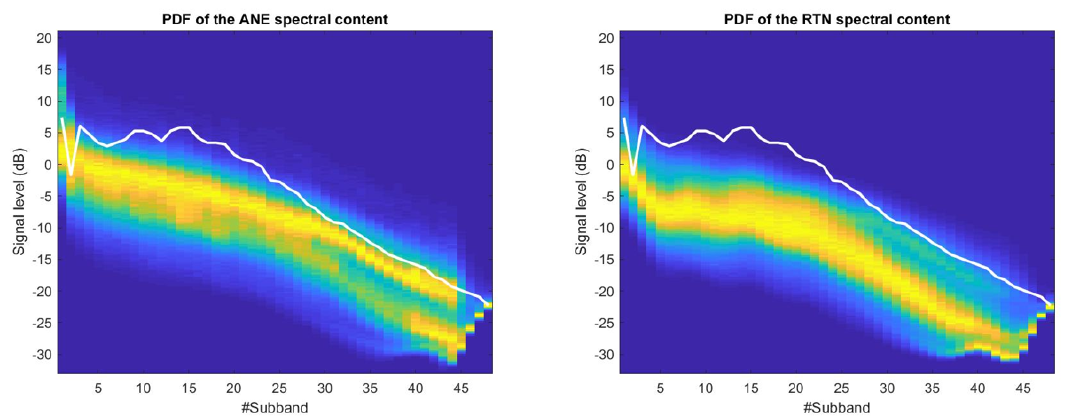
Figure 5. 2D-PDF of the ANE ( left ) and the RTN ( right ) of the urban dataset. The frequency subband index i corresponding to the MFS is labelled in the x-axis (the reader can find the corresponding frequency in Table 1), while the corresponding logarithmic signal level at each subband is depicted in the y-axis in dBs. The Figures colormap is blue for lower probabilities while tends to warm colors (with the maximum in red) for higher probabilities. The solid white line draws the optimum decision threshold for the one-band linear discriminant classifier at each frequency